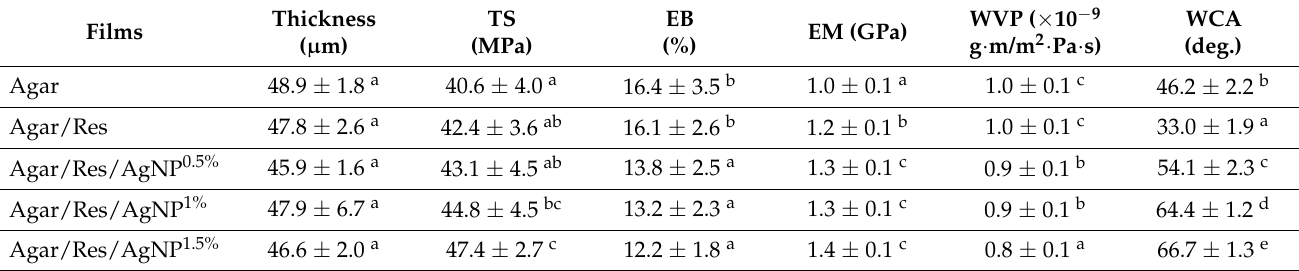
Table 2. Mechanical properties, WVP, and WCA of the agar-based composite